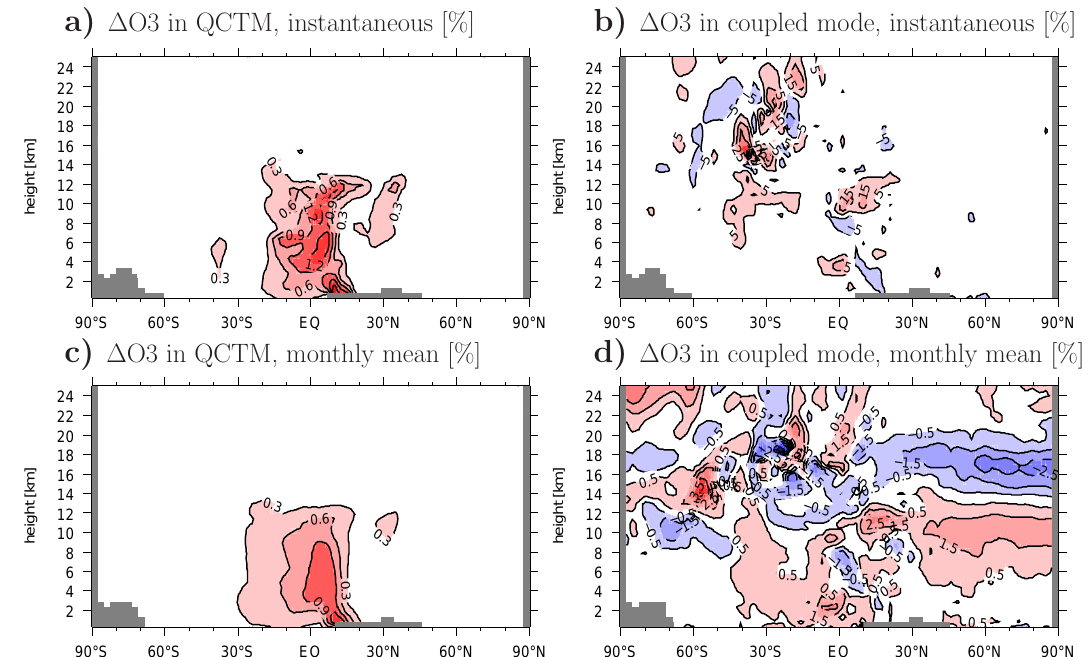
Fig. 4. Latitude-height section of the relative difference in O 3 mixing ratios between sensitivity and reference simulation in QCTM (left) and fully coupled mode (right). The sensitivity simulation has 5% stronger emissions from biomass burning of NO x , CO, and NMVOC, affecting O 3 mixing ratios chemically (see text). Results are shown for the Greenwich Meridian for a single month under July conditions: 00:00UTC on 1 July (top), monthly mean (bottom). Isoline intervals are 0.3% in QCTM (left), but 10% in coupled mode for the instantaneous case (top right), and 1% for the monthly mean (bottom right). Positive values (red) denote higher O 3 mixing ratios for the sensitivity simulation.